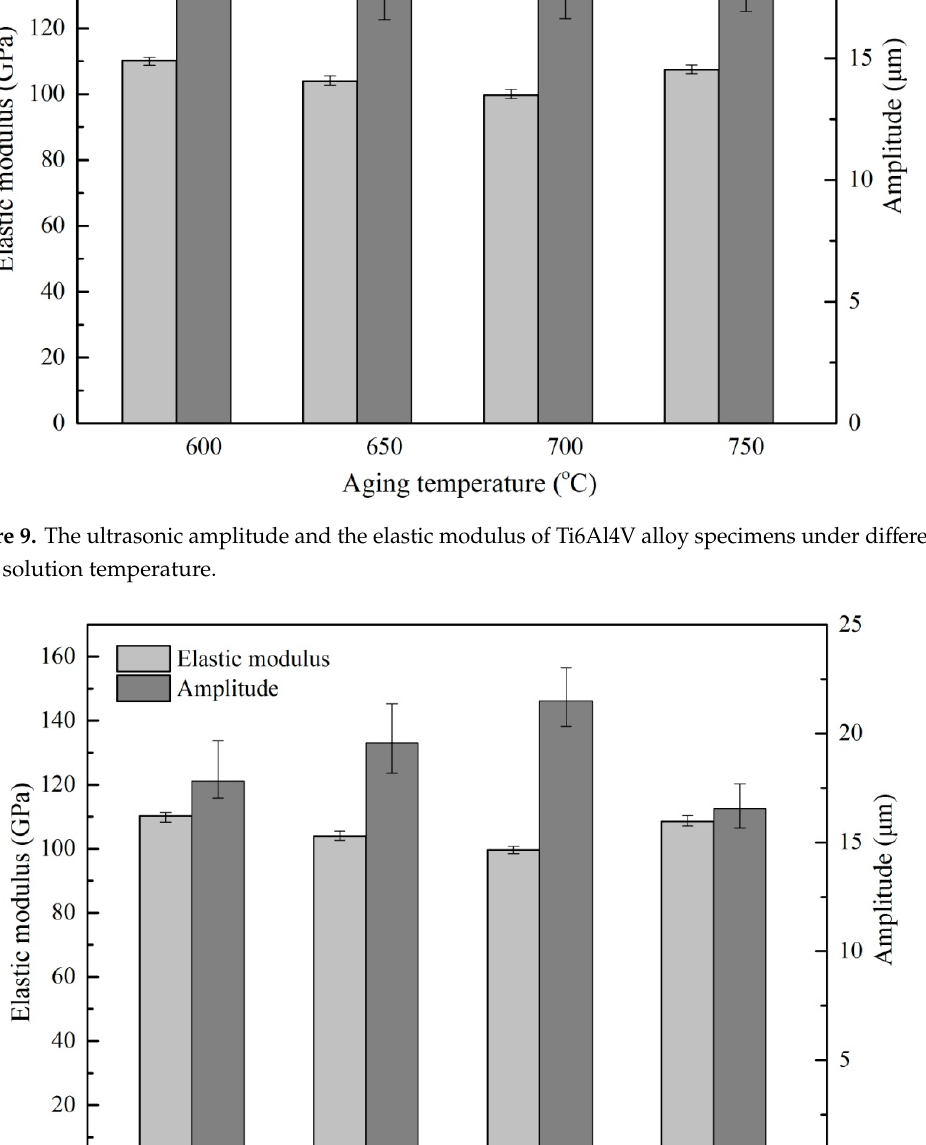
Figure 10. The ultrasonic amplitude and the elastic modulus of Ti6Al4V alloy specimens under different aging temperature.